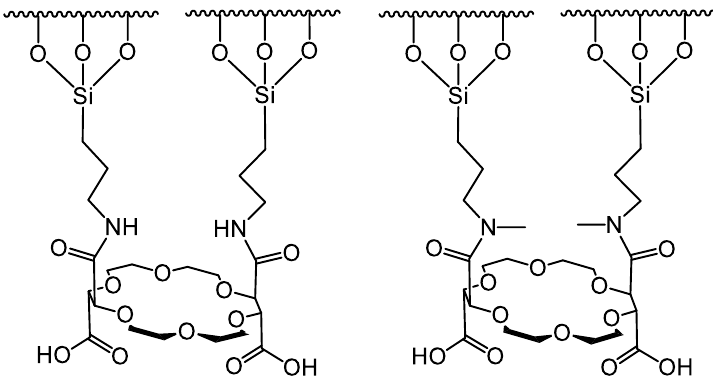
Figure 7. Structures of CSPs applied in Refs. [43,44].